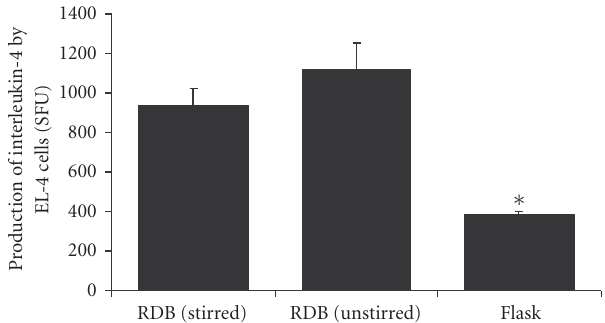
Figure 9: Cytokine production in bioreactor cultures. Graph of interleukin-4 production by EL-4 colonies after culture in rotating disc bioreactors with stirring (Re = 600) or without, compared to values of static flask cultures. Bars represent the means of 3 experi- mental groups; error bars represent standard error of the mean; the asterisk pertains to P < .